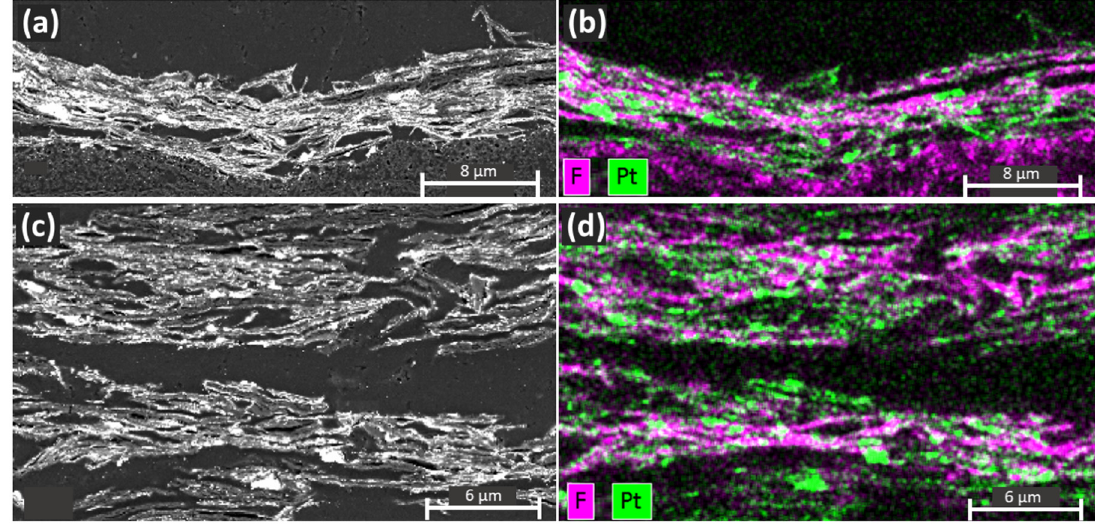
Figure 3. Cross-sectional SEM images and EDS (Pt and F) elemental maps of graphene CLs: ( a , b ) SEM image and EDS map of graphene based CL prepared without urea; ( c , d ) SEM image and EDS map of graphene-based CL prepared without urea.